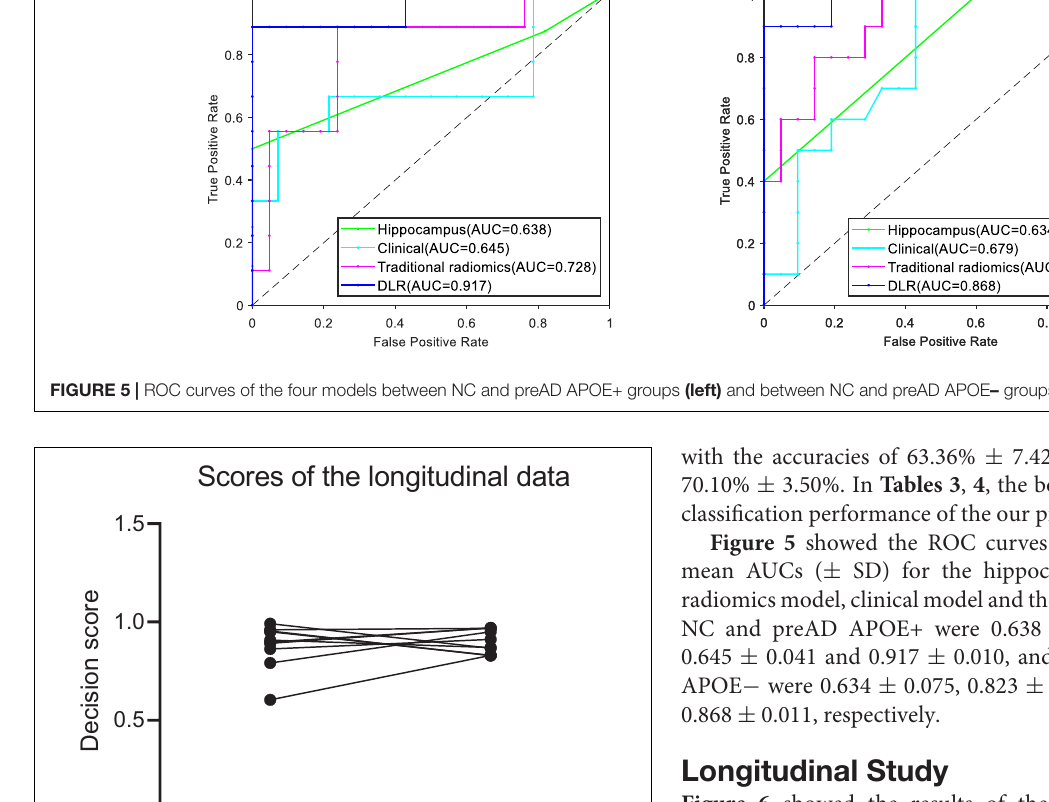
Figure 4 presented the ROC curves of the four